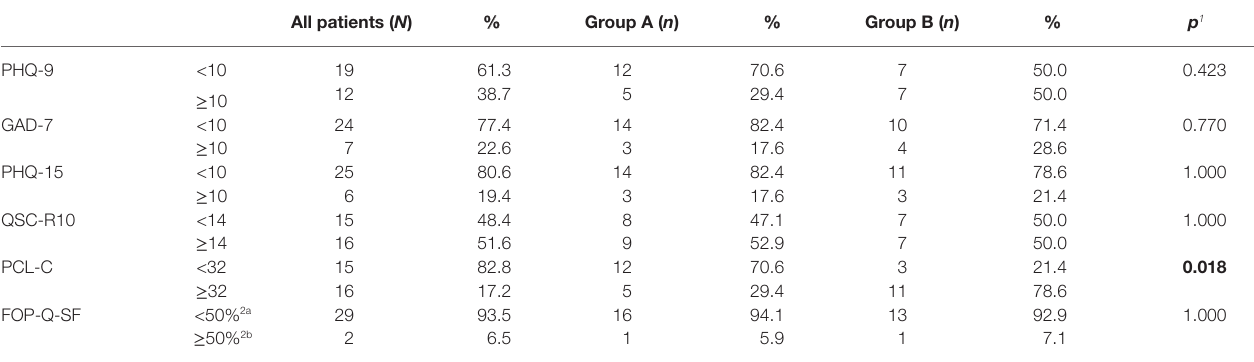
TABLE 2 | Frequency differences between